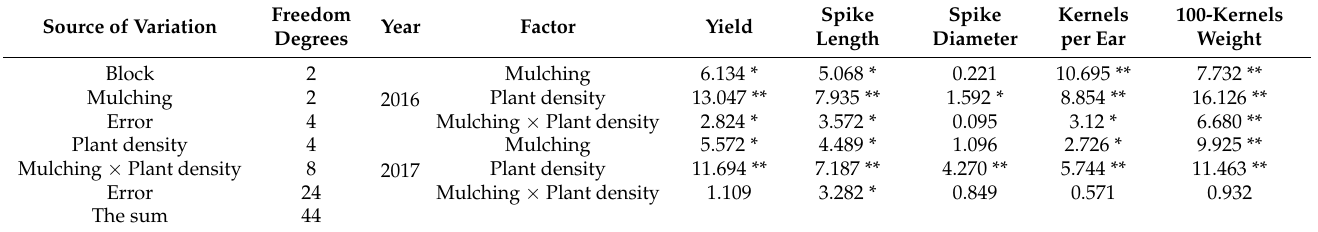
Table 3. Variance analysis of yield and its components under different treatments. The data in the table are F values. * indicates significantly different at p < 0.05 level. ** indicates significantly different at p < 0.01